Question: Draft a figure caption describing what is shown.
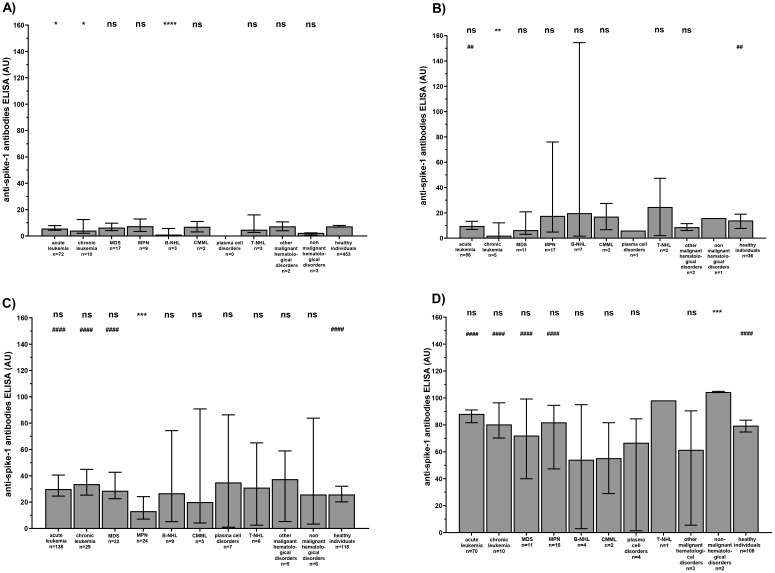
Answer: Reactivity of IgG-anti-spike-1-antibodies in patients with different hematological disorders and healthy controls in relation to the number of vaccinations (A) before vaccination, (B) after 1 st vaccination, (C) after 2 nd vaccination, (D) after 3 rd vaccination. AU: arbitrary units; ns: not significant. Median ± 95% CI is given. Significance levels as compared to healthy individuals: n.s. = not significant; *p < 0.05; **p < 0.01; ***p < 0.001; Significance levels as compared to baseline reactivity before first vaccination: # p < 0.05; ## p < 0.01; ### p < 0.001; #### p < 0.0001. MDS, myelodysplastic syndrome; MPN, myeloproliferative neoplasms; NHL, Non-Hodgkin lymphoma; CMML, chronic myelomonocytic leukemia.